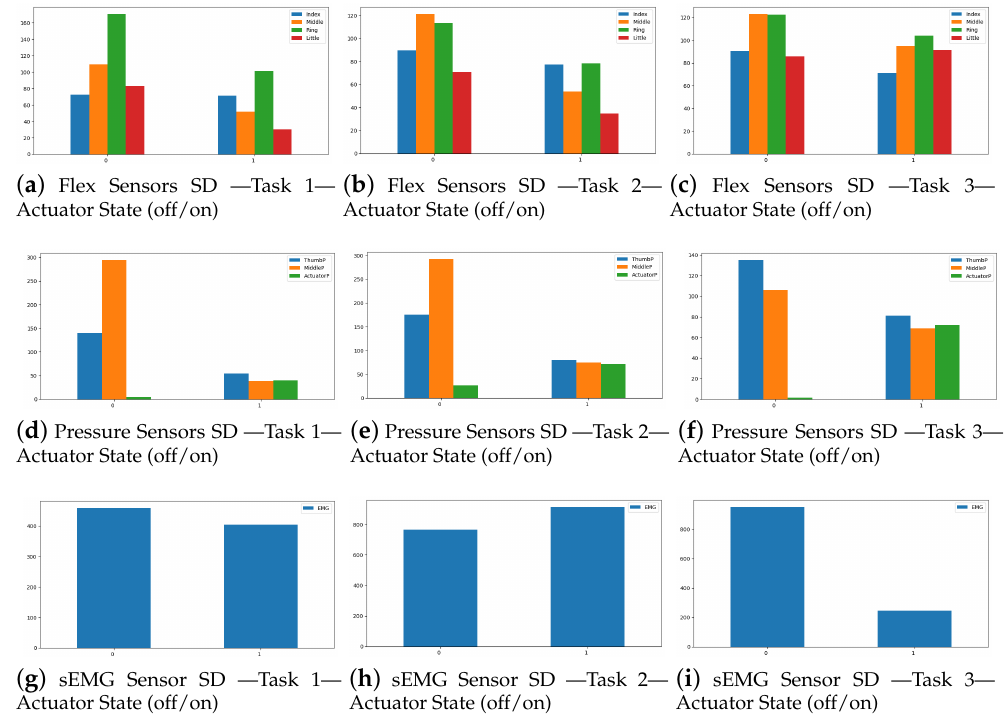
Figure 6. Soft robotic glove validation experiment results visualizing the standard deviation for each sensor between the Off and On actuator states during the three experiment tasks. More specifically, subfigures ( a ) , ( b ), ( c ) indicate flex sensor SD results for the index, middle, ring, and little finger, respectively. Subfigures ( d ), ( e ), ( f ) indicate pressure sensor SD results for the thumb tip and middle finger tip and top, respectively. Subfigures ( g ), ( h ), ( i ) indicate sEMG sensor SD results of the extensor muscle activity.